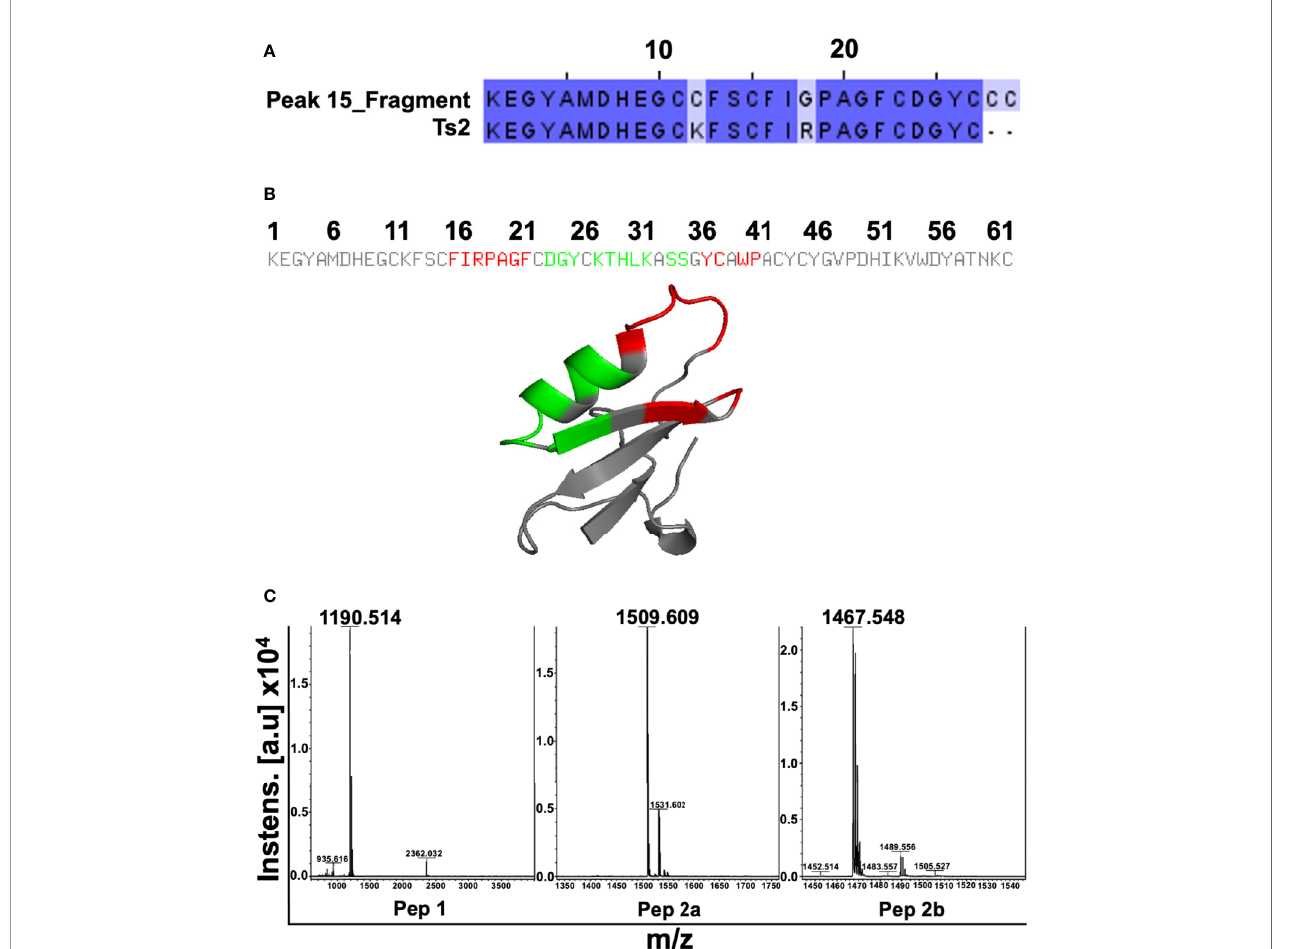
FIGURE 4 | Characterization of Sub6-B subfraction and mimetic peptide production. In order to characterize the molecule (peptide) present in Sub6-B, it was sequenced by Edman degradation, elucidating its partial amino acid sequence: KEGYAMDHEGCCFSCFIGPAGFCDGYCCC … . The next step was to compare this sequence with other sequences available on the online public data bank (BLAST). Sub6-B (Peak_15) sequence had a high (93%) identity with T. serrulatus Ts2 toxin (showing conserved amino acids in dark blue and different amino acids in light blue, of which, 27 out of 29 aa of the fragment aligned with Ts2 toxin) (A) . Primary and tertiary structures of conformation peptides were designed based on the Ts2 structure. Peptide 1 is highlighted in red and Peptide 2 in green (B) . The purity of Pep1, Pep2a, and Pep2b was analyzed using MALDI-TOF-TOF mass spectrometry (C)